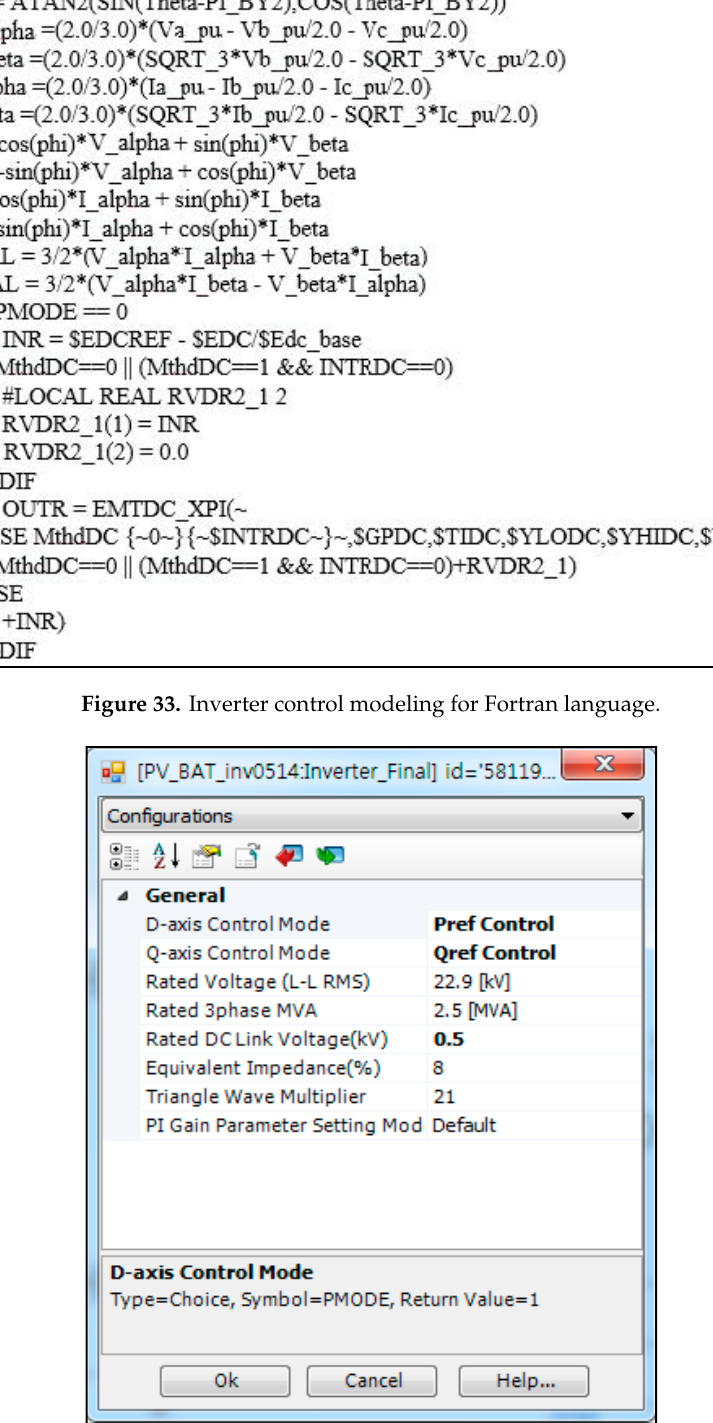
Figure 34. Inverter parameter input.